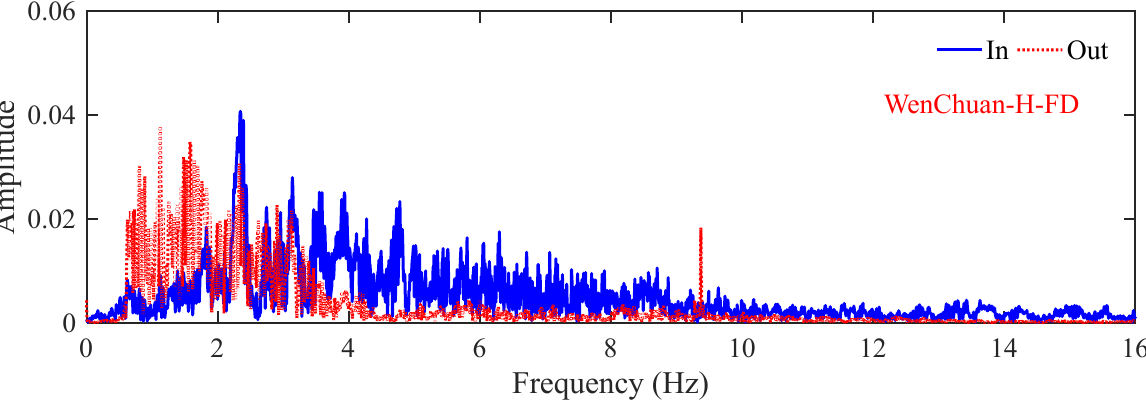
Figure 7. Comparison of the frequency distribution of the input and output seismic waves of cen ‐ trifuge shaking table.